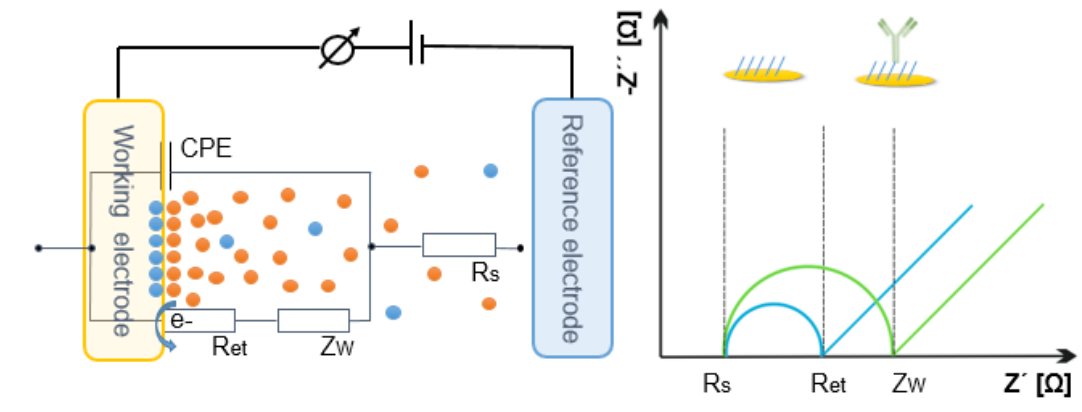
Figure 5: A schematic equivalent circuit with electrochemical processes occurring on the working electrode surface (on left); Immunosensor based on EIS with an increase in R after successful immobilization of antibody (on right). et